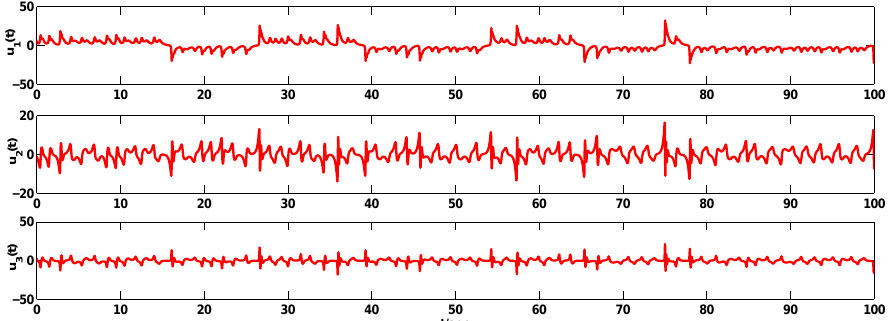
Figure 3. Time response of the states u 1 ( t ) , u 2 ( t ) , u 3 ( t ) of the drive system (13) with fractional order q = 0.95.